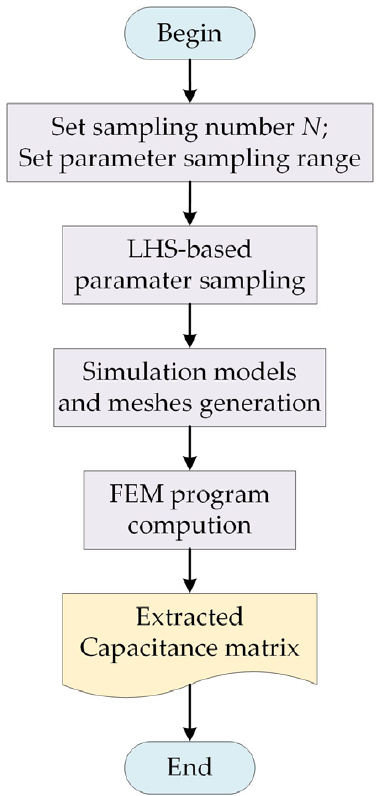
Figure 3. The flow of datasets acquisition.